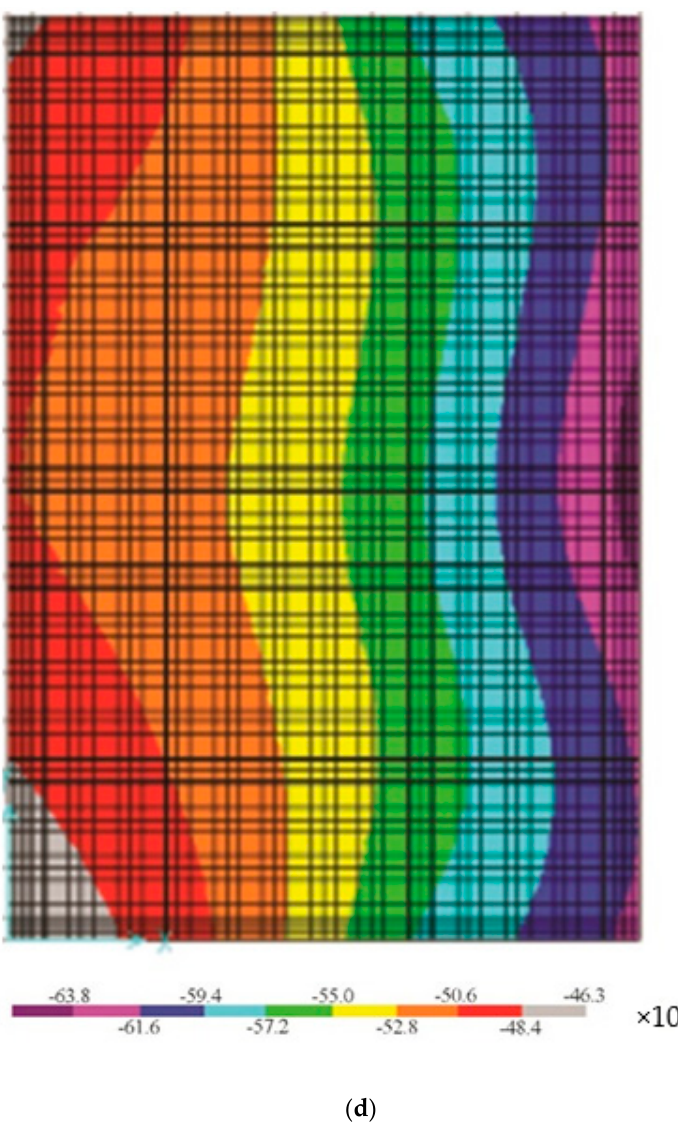
Figure 5. Deformation of the eight-story building with type 1 loading ( a ) structure, ( b ) foundation in ANSYS, ( c ) foundation (with the constant Ks ) in SAFE, ( d ) foundation (with variable Ks ) in SAFE. Then, the model with variable Ks was analysed and the weight of the used reinforce- ments was calculated. The results are presented in Table 2. In another case, the foundation was modelled with a constant subgrade reaction modulus of Ks = 1 × 10 4 kN/m 3 and the weight of the used reinforcements was obtained (Table 2). It can be seen the value of the same Ks in the first row and the domain of variable values of Ks in the second row related to six-, eight-, and 10-story buildings in this table. The last column of this table shows the used weight of reinforcement for buildings with different numbers of stories, with the same Ks and with variable Ks . It can be seen that by using variable Ks , the weight of the required reinforcement of the foundation was reduced by 32%, 37%, and 38% for six-, eight-, and 10-story buildings respectively and it is economical for engineers [40]. Nowadays reliability analysis is considered for uncertainty in exact values of soil parameters [41–43] and it will be considered in next study in combination with soil-structure interaction